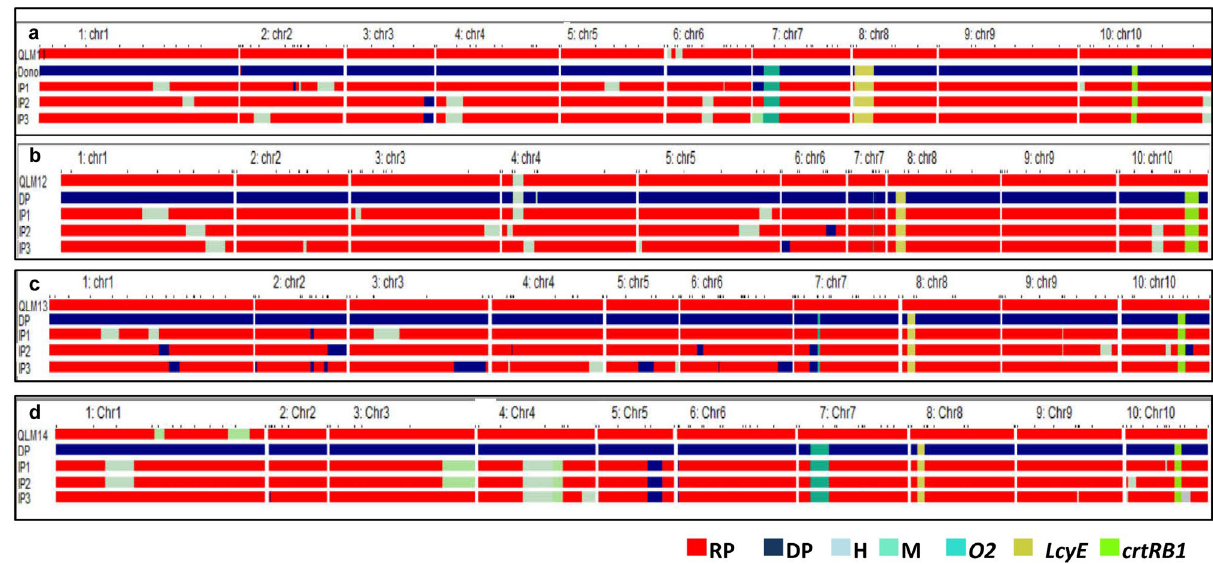
Figure 1. Graphical genotype of selected BC 2 F 1 progenies across the four crosses. ( a ), QLM11 × HP467-15// QLM11; ( b ), QLM12 × HP467-15//QLM12; ( c ), QLM3 × HP467-15//QLM13; ( d ), QLM14 × HP467-15//QLM14. DP, Donor Parent; IP, Introgressed progeny; Chr, Chromosome.